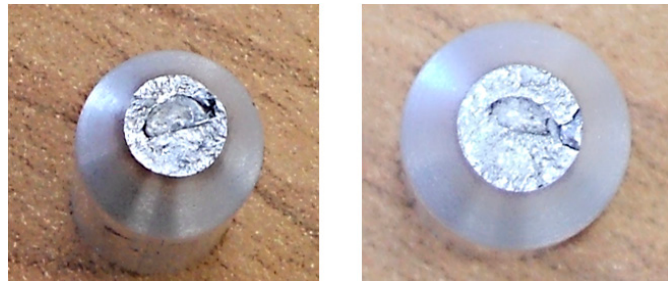
Figure 10. The diagram of the static tension test performed in the welded material EN AW 6063.T66 with preheating ( a ) in the case of the beta-geometry of the weld surface, and ( b ) in the case of gamma- geometry.